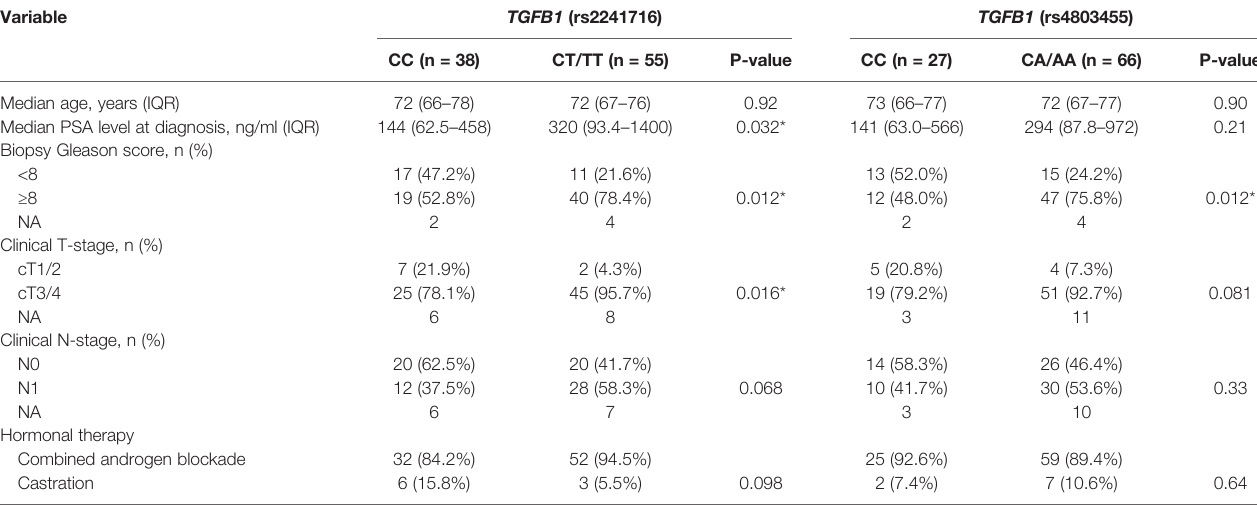
TABLE 2 | Clinicopathological characteristics of patients with metastatic prostate cancer according to TGFB1 polymorphisms.